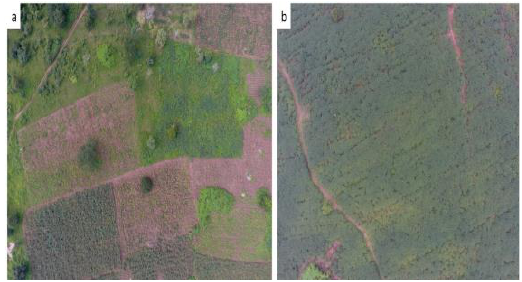
Figure 3. UAV images showing (a) traditional small- scale farm, and (b) mechanised